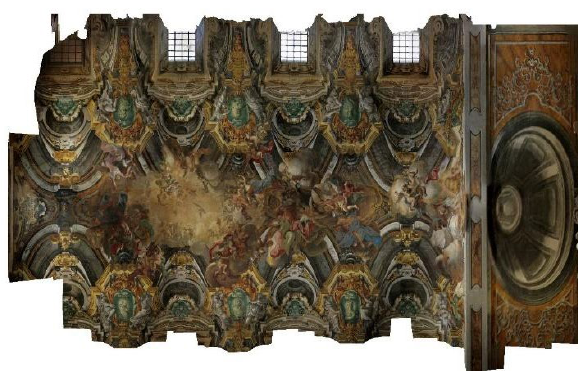
Figure 9. Cylindrical projection of the geometry of the vault and